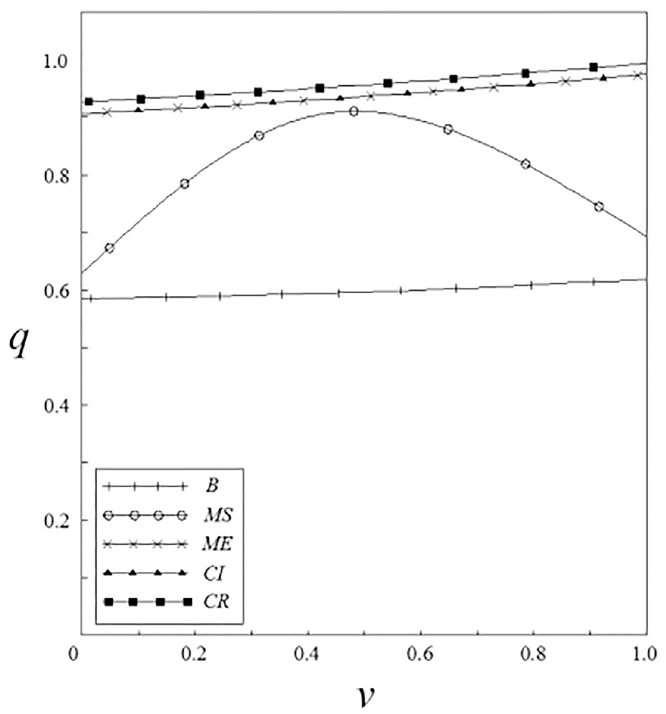
Fig 5. The relationship between q and ν .